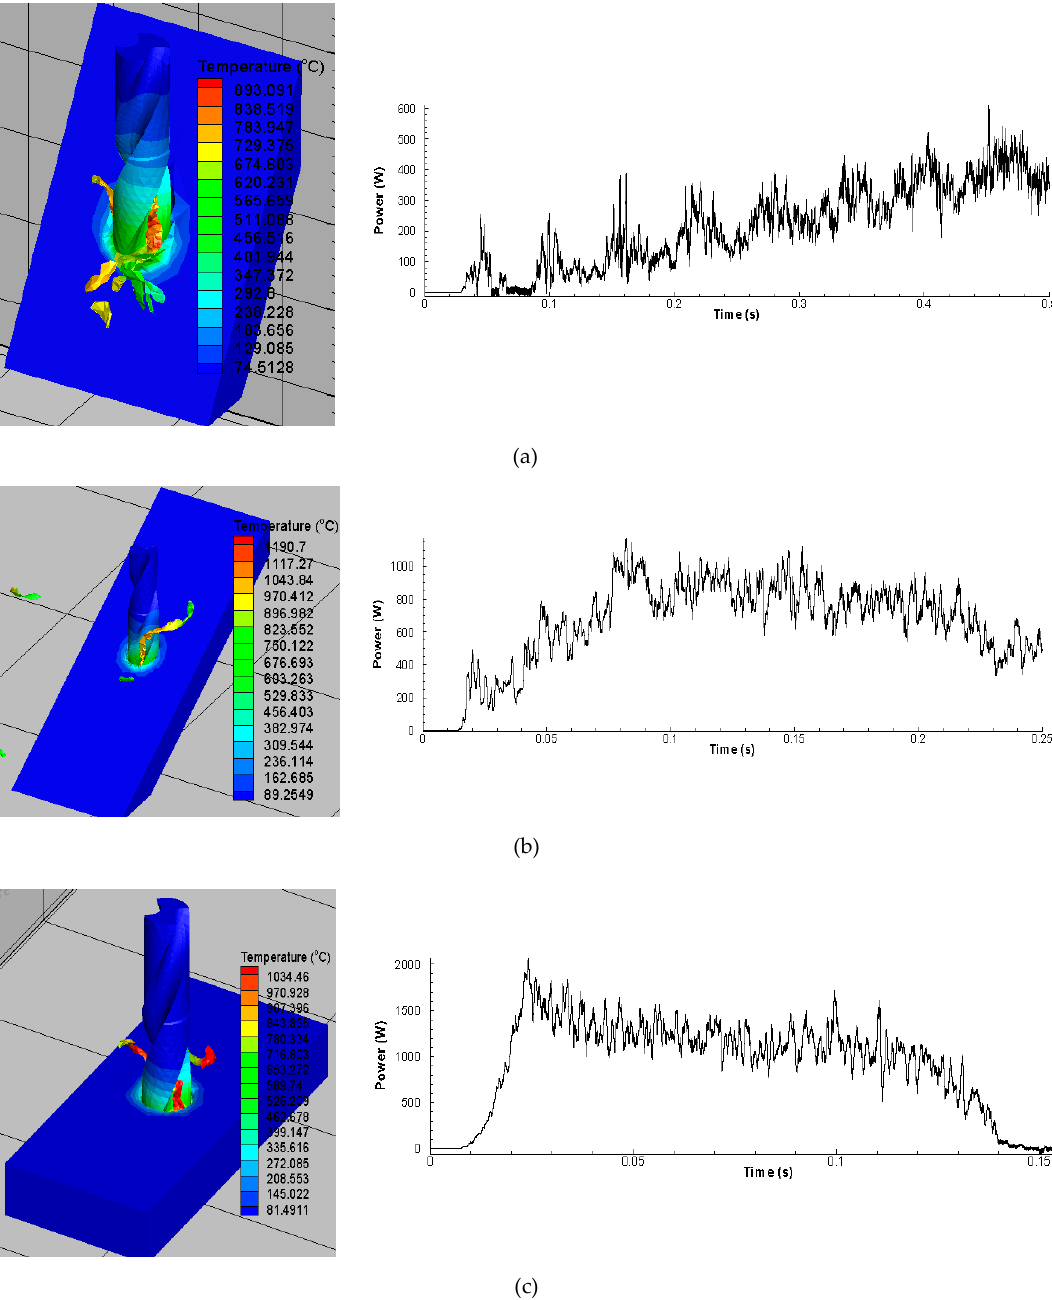
Figure 7. Power signal captured ( a ) FE Simulation of 30° inclination angle (0.5 mm/rev,1000 spindle Figure7. Powersignalcaptured( a )FESimulationof30 ◦ inclinationangle(0.5mm / rev, 1000 spindle rpm) rpm) ( b ) FE Simulation of 60° inclination angle (0.5 mm/ rev,2000 spindle rpm) ( c ) FE Simulation of ( b ) FE Simulation of 60 ◦ inclination angle (0.5 mm / rev, 2000 spindle rpm) ( c ) FE Simulation of 90 ◦ 90° inclination angle (0.5 mm/ rev,3000 spindle rpm). inclination angle (0.5 mm / rev, 3000 spindle